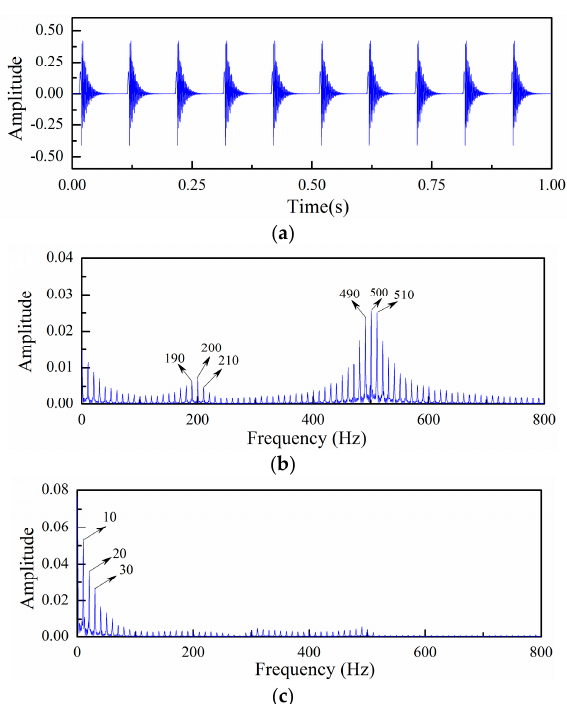
Figure 6. The analytic results of bearing multi-cycle fault signal; ( a ) The time domain waveform; ( b ) The frequency domain waveform; ( c ) The envelope spectrum.